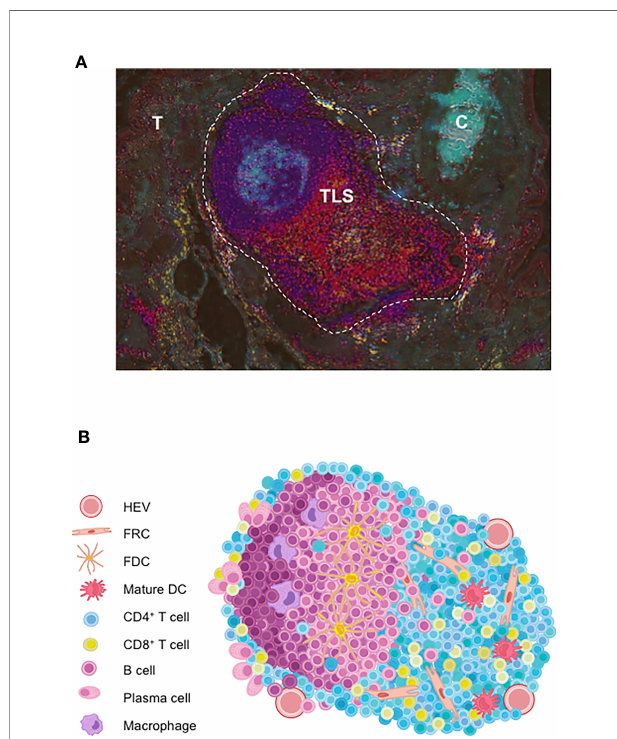
FIGURE 1 | Cellular organization of tumor-associated TLS. (A) Full TLS image of lung tumor sections in a NSCLC patient. Brie fl y, two serial tumor sections were respectively double-immunostained for CD3/DC-Lamp and CD20/CD21. Then color deconvolution and contrast inversion (using ImageJ) was applied as described (10). Shown are CD3 + T cell-rich areas (red); DC-Lamp + mature DC (yellow) adjacent to the CD20 + B-cell rich areas (dark blue) and CD21 + FDC (light blue) of a TLS close to tumor nests (T) and bronchial cartilage (C). Magni fi cation: x100. (B) TLS are well- organized functional immune ectopic aggregates in the close vicinity to HEV. TLS comprise a T-cell zone containing mature DC and FRC; and a B- cell zone with a germinal center with PC, macrophages and FDC. C, bronchial cartilage; DC, dendritic cell; FDC, follicular dendritic cell; FRC, fi broblastic reticular cell; HEV, high endothelial venule; PC, plasma cell; T, tumor